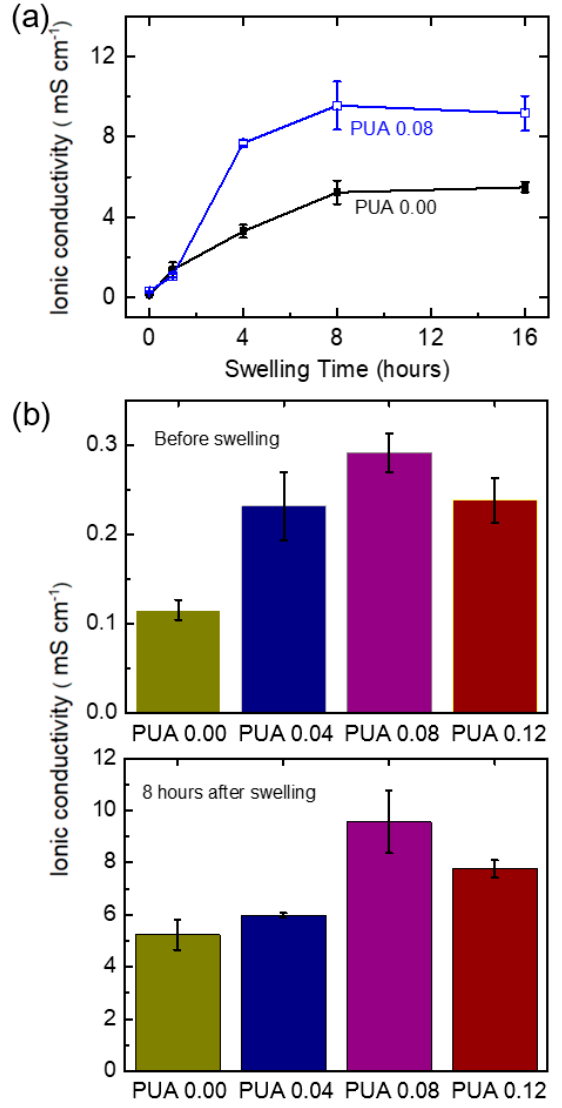
Figure 5. Ionic conductivities of ( a ) PUA 0.08 and PUA 0.00 in the case of different swelling times. PUA membranes ( b ) before swelling and ( c ) after 8 h of swelling.